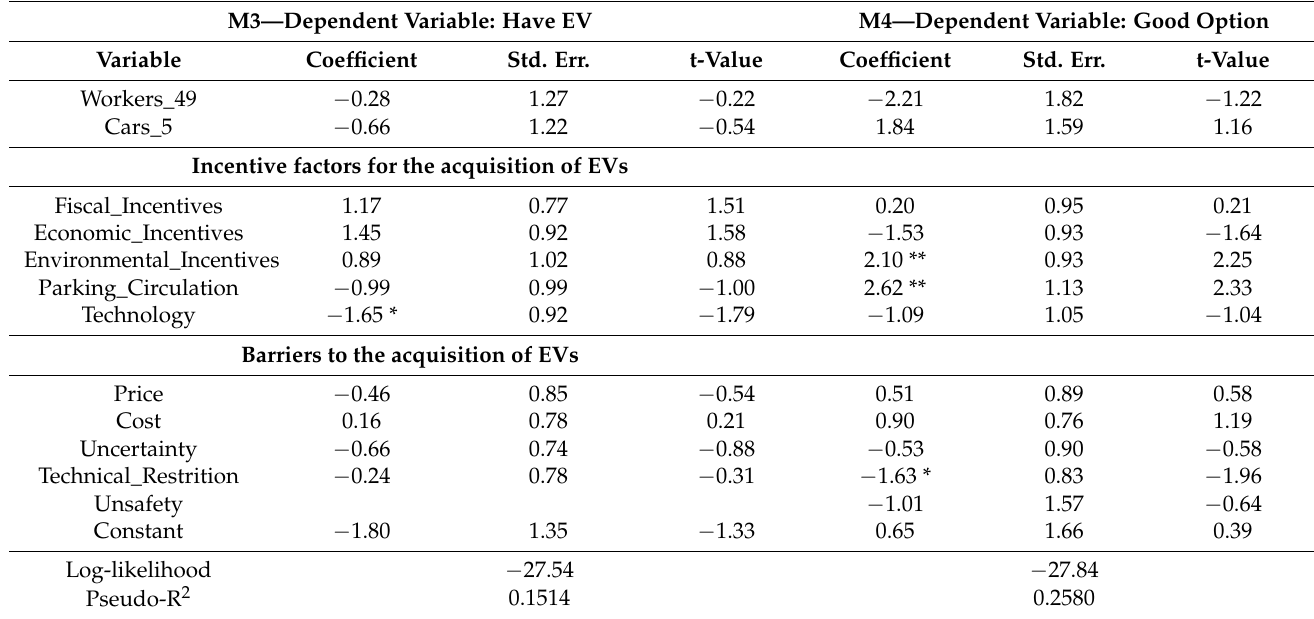
Table 8. Binary Logit Model Results for the Business